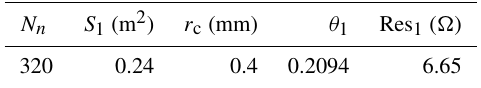
Table 5. Geometric parameters of SHS 4 (supplied with I 1 = I 2 = 1 . 4A).